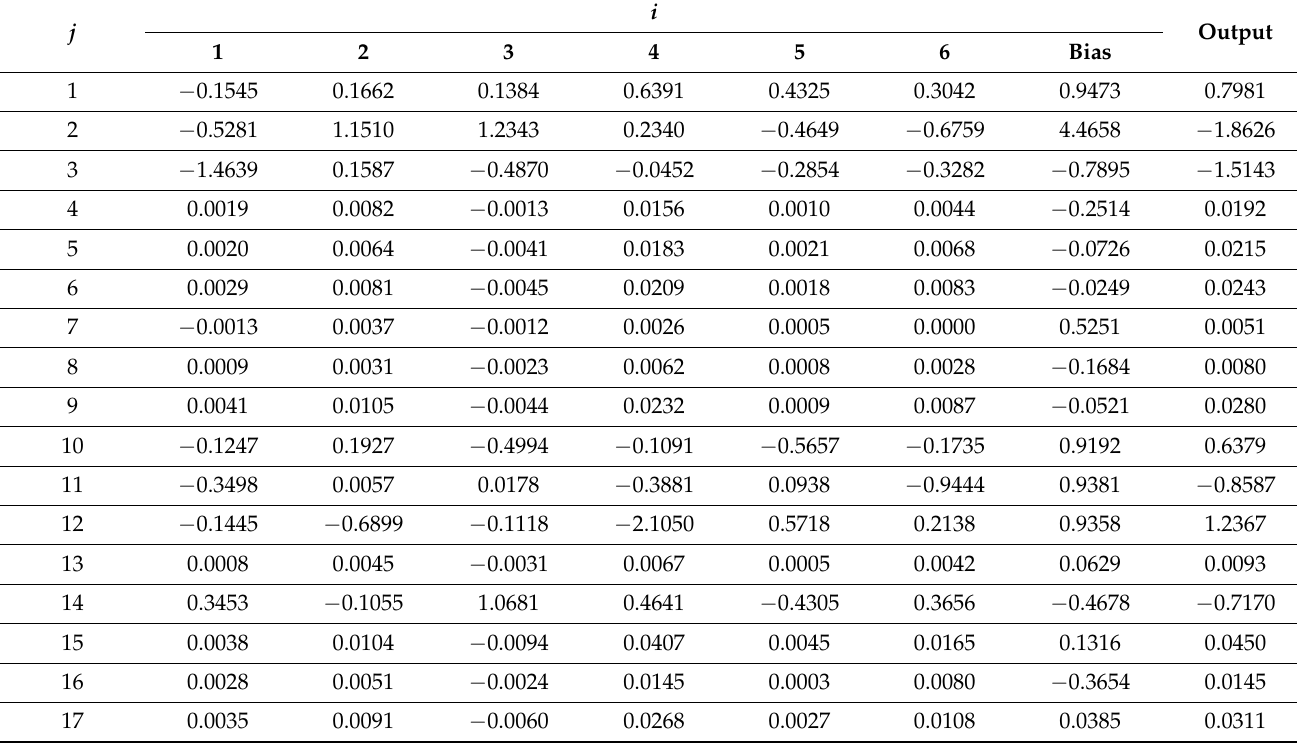
Table A2. Weights of Hidden Layer of